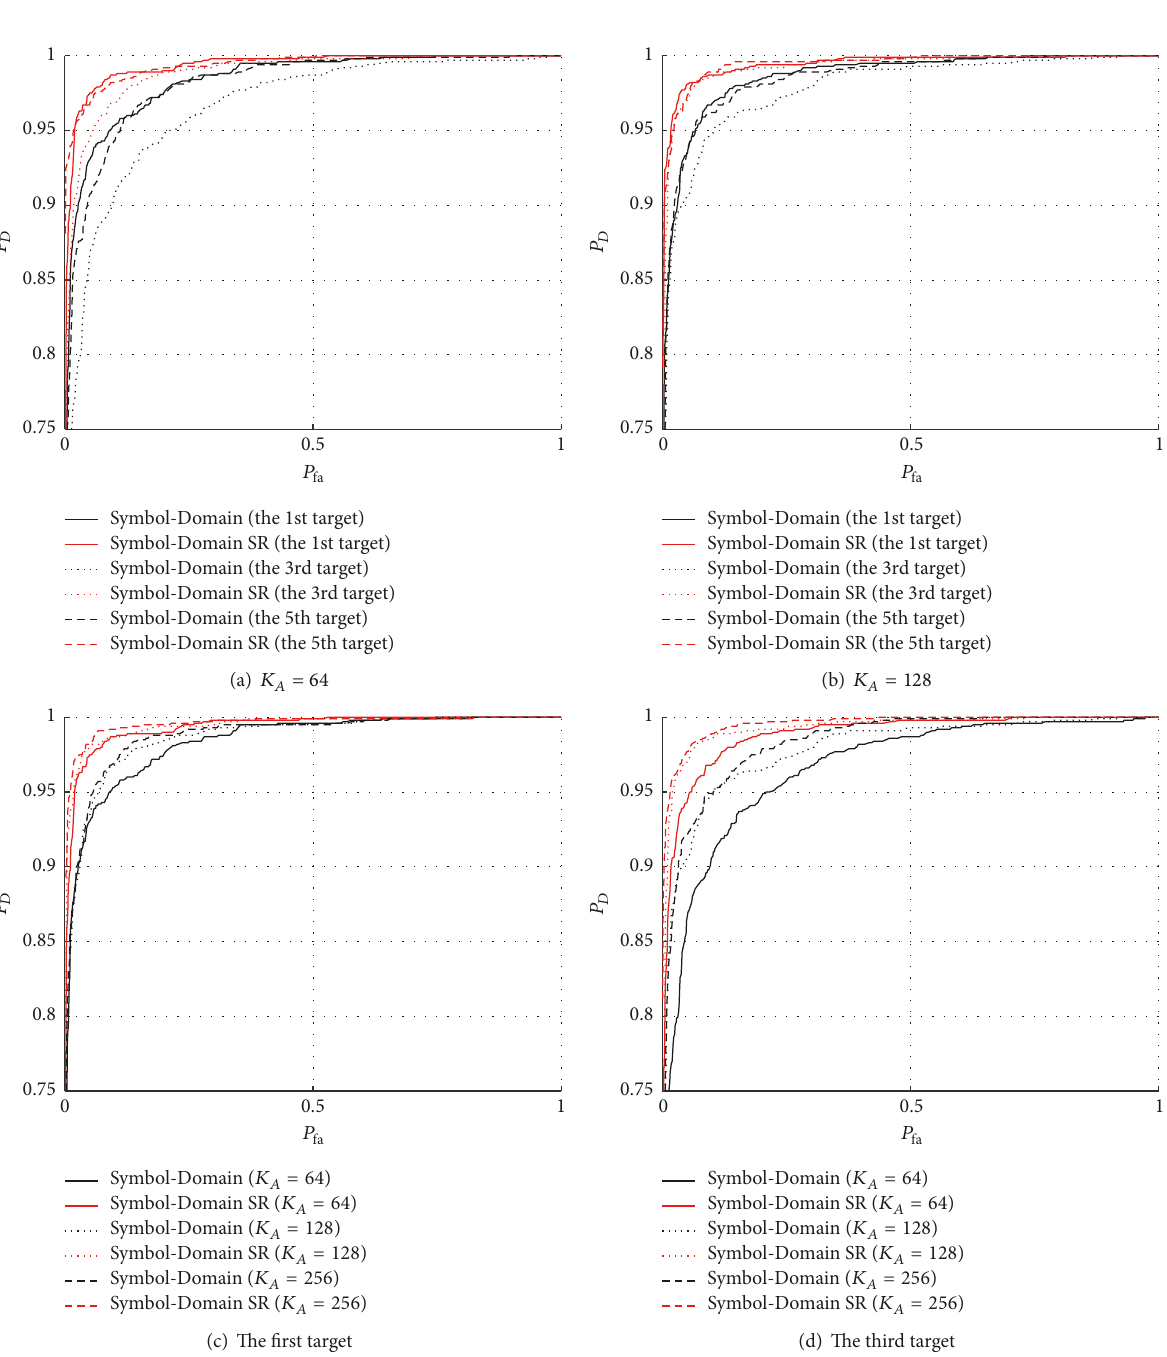
Figure 7: Receiver operating characteristic (ROC) curves for targets with different number of